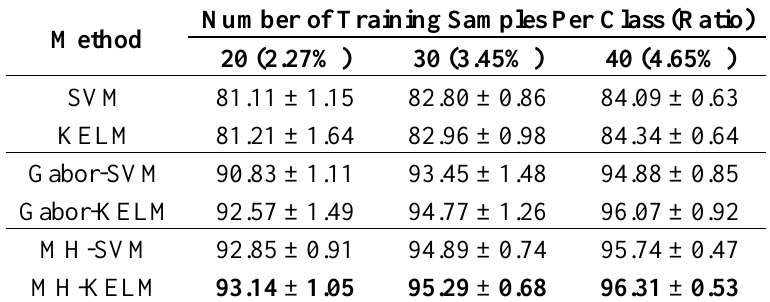
Table 5. Overall classification accuracy (%)—mean ± standard deviation over 10 trials using a varying number of labeled training samples (ratio represents the proportion of labeled training samples and samples to be classified) per class for the University of Pavia